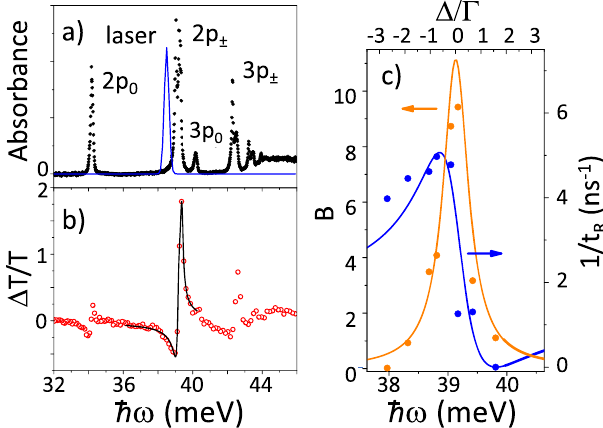
Fig. 3 Spectral dependence of induced transmission and continuum structure with the Fano pro fi le. a The small-signal absorbance spectrum. The main transitions are labelled according to the excited states (all originating from the 1 s (A 1 ) ground state). The laser spectrum corresponding to the off-resonance photon energy used in Fig. 2c is shown as a blue line. b Wavelength dependence of the pump-probe signal, Δ T / T , with fi xed pump power (same as in Fig. 2c) and fi xed time delay of t = 15ps between pump and probe as a function of photon energy, ħ ω . The solid curve is the result of a fi t to the data using Eq. (1) as described in the Methods. c The recombination rate (blue symbols), 1/ t R , and bleaching (orange symbols), B , found from fi tting the data in Fig. 2c. The solid curves are the results of a global fi t using Eq. (1) for the ionization (blue line) and a Lorentzian for the bleaching (orange line). The top axis shows the detuning Δ in units of the width from the fi t, Γ